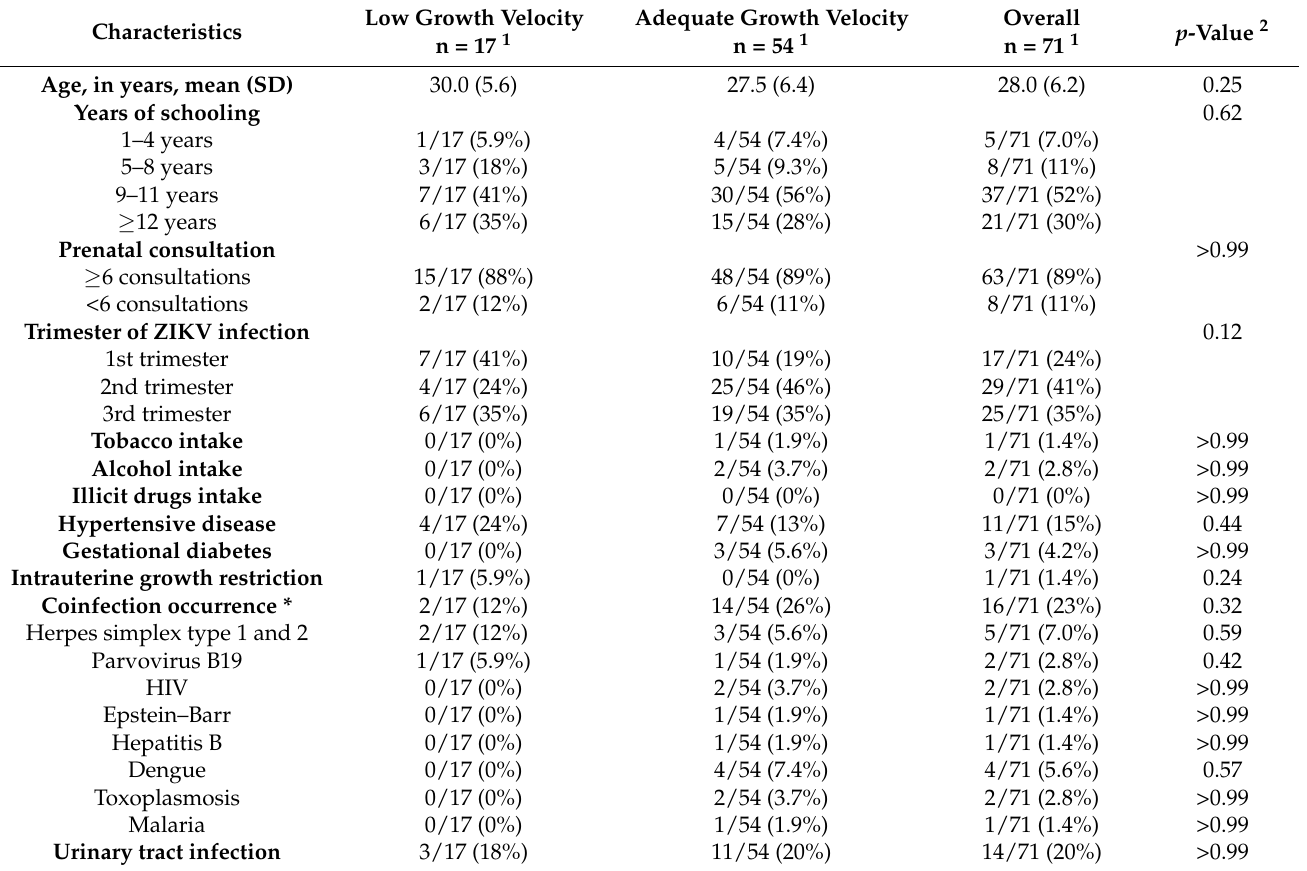
Table 1. Sociodemographic and clinical characteristics of pregnant women with positive RT-PCR for Zika virus, distributed according to the children’s growth velocity, Amazonas,